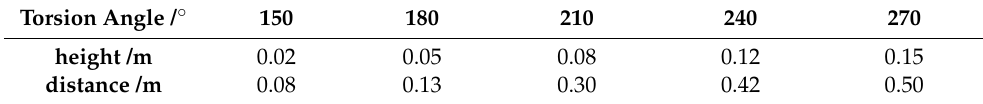
Table 7. Relationship between torsion angle of spring and jump height and